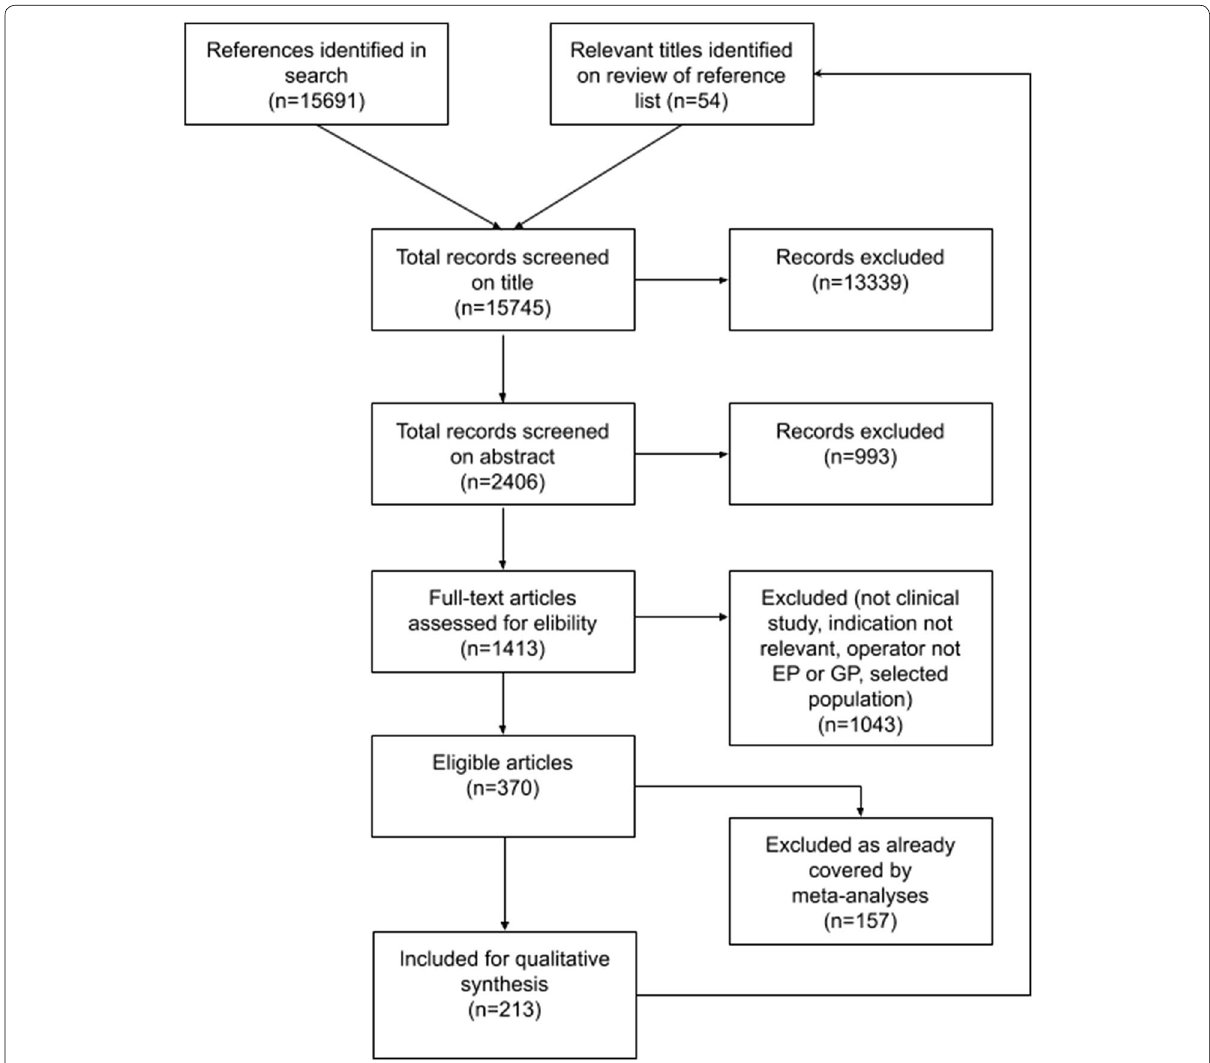
Fig. 1 Study selection flow